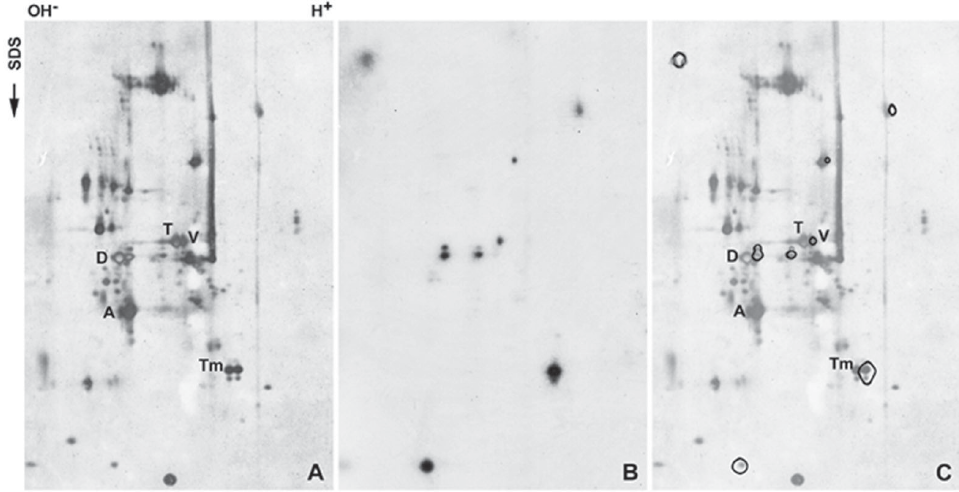
Figure 2. Two-dimensional elec- trophoresis of an extract of the cytoskeleton of 1-day-old cul- tured mouse heart cells. A , Pro- teins detected with silver stain- ing; B , corresponding autoradio- gram of cells incubated with 32 P for 1 h, and C , A and B superim- posed, where the image of B has been outlined digitally. After 1 h of incubation, only a few proteins, particularly desmin, are phosphorylated, while other pro- teins known to be phosphorylat- able, such as actin and tubulin, do not incorporate phosphate. The proteins have been identi- fied by their relative positions as: D = desmin, A = actin, T = tubulin, V = vimentin, and Tm = tropomyosin. Left is basic (OH - ) and right is acid (H + ). SDS = so- dium dodecyl sulfate. The arrow indicates the second dimension, from high to low molecular weight. For detailed conditions, see Ref.